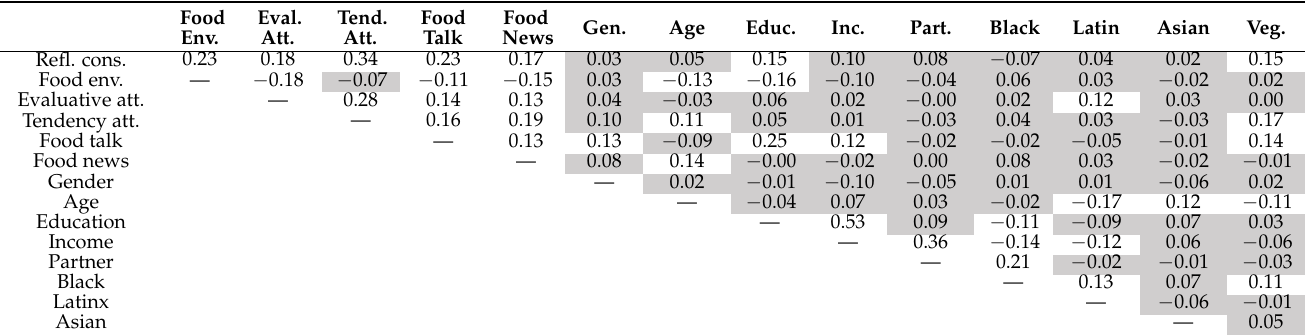
Table 2. Correlations among all variables.